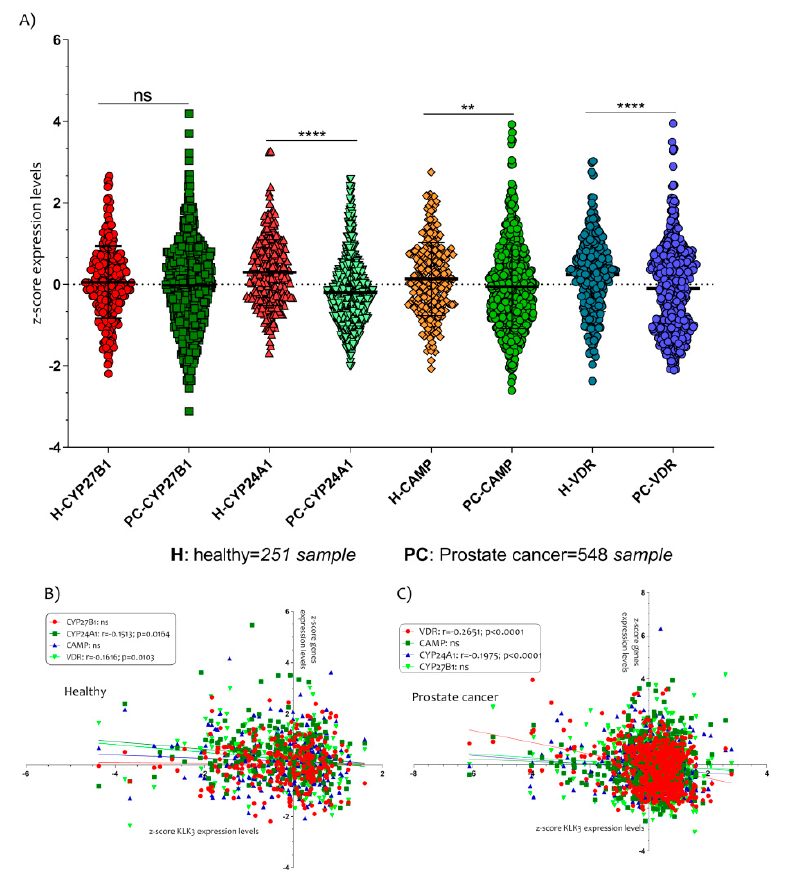
Figure 4. The Vitamin D metabolism genes modulated in PCa patients. ( A ) The expressions of CYP24A1, CAMP and VDR were significantly down-regulated in PCa patients compared to healthy controls subjects. Also, the expression levels of VDR and CYP24A1 were correlated negatively with KLK3 in healthy ( B ) and in PCa patients ( C ). Data are expressed as expression levels and presented as vertical bars. p values < 0.05 were considered to be statistically significant (** p < 0.005; **** p < 0.00005). All genes, except CYP27B1 ( p = ns), were downregulated in PCa patients compared to